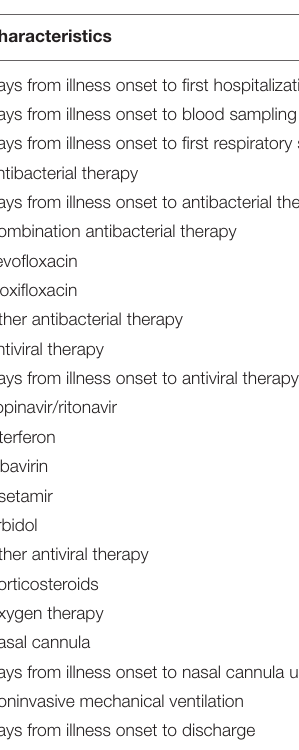
TABLE 3 | Management and